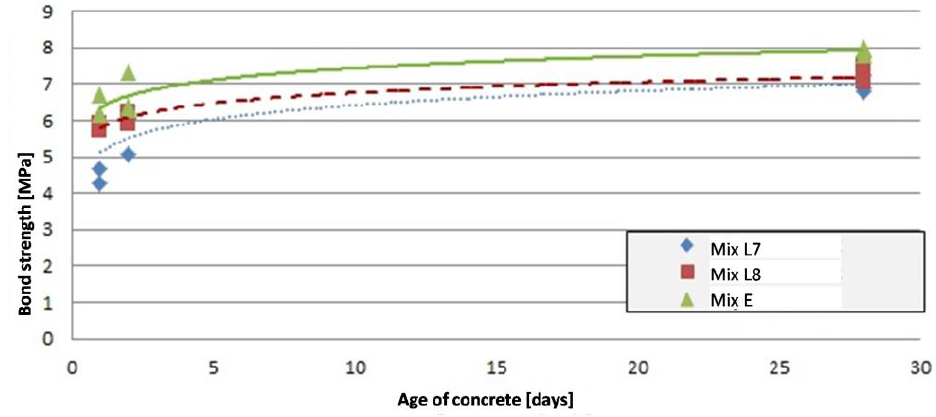
Figure 2. Bond strength as function of concrete age (LWAC: Mix L7 and L8; NWAC: Mix E).